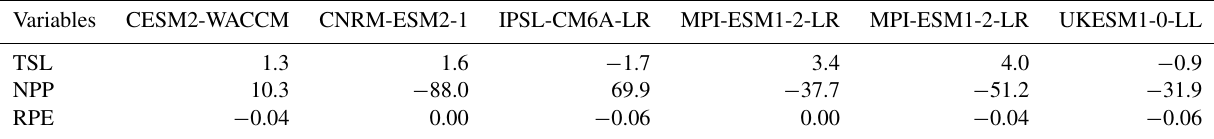
Figure 3. Bias correction of rhizosphere priming effect (RPE) ratio. Mean RPE ratio in the permafrost region before (top row) and after (bot- tom row) bias correction. RPE ratio is calculated from gross primary productivity (GPP). The bias correction offsets for each ESM are shown in Table 2. Table 2. Bias correction mean offsets of TSL, NPP, and RPE. Mean offsets of soil temperature (TSL; ◦ C), net primary productivity (NPP; gm − 2 yr − 1 ), and rhizosphere priming effect (RPE; unitless) for all scenarios over the period 2015–2020. Negative values represent that reference data are smaller than the original ESM